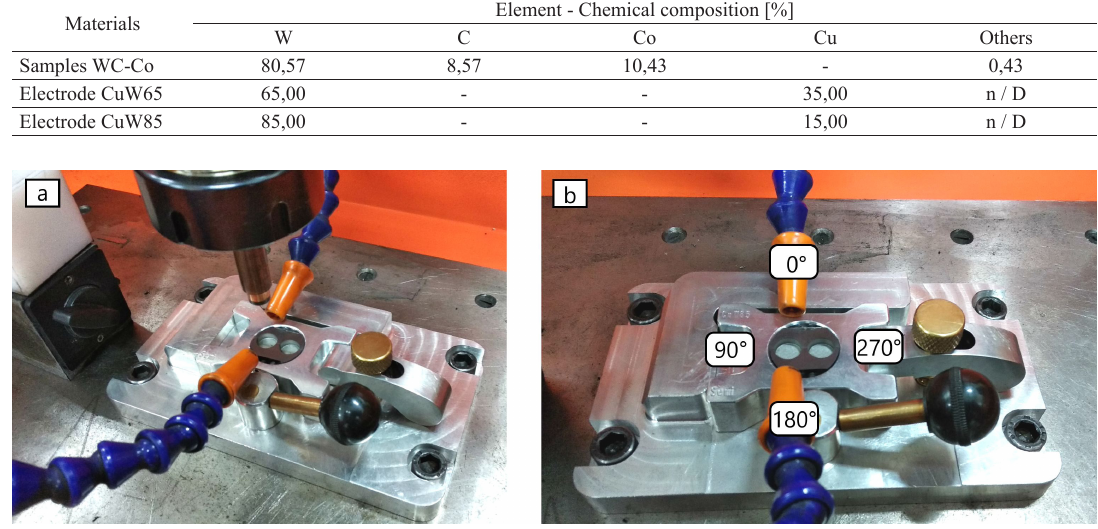
Figure 1. (a) Assembly device for samples and electrodes clamping and (b) positions for circularity measurements.